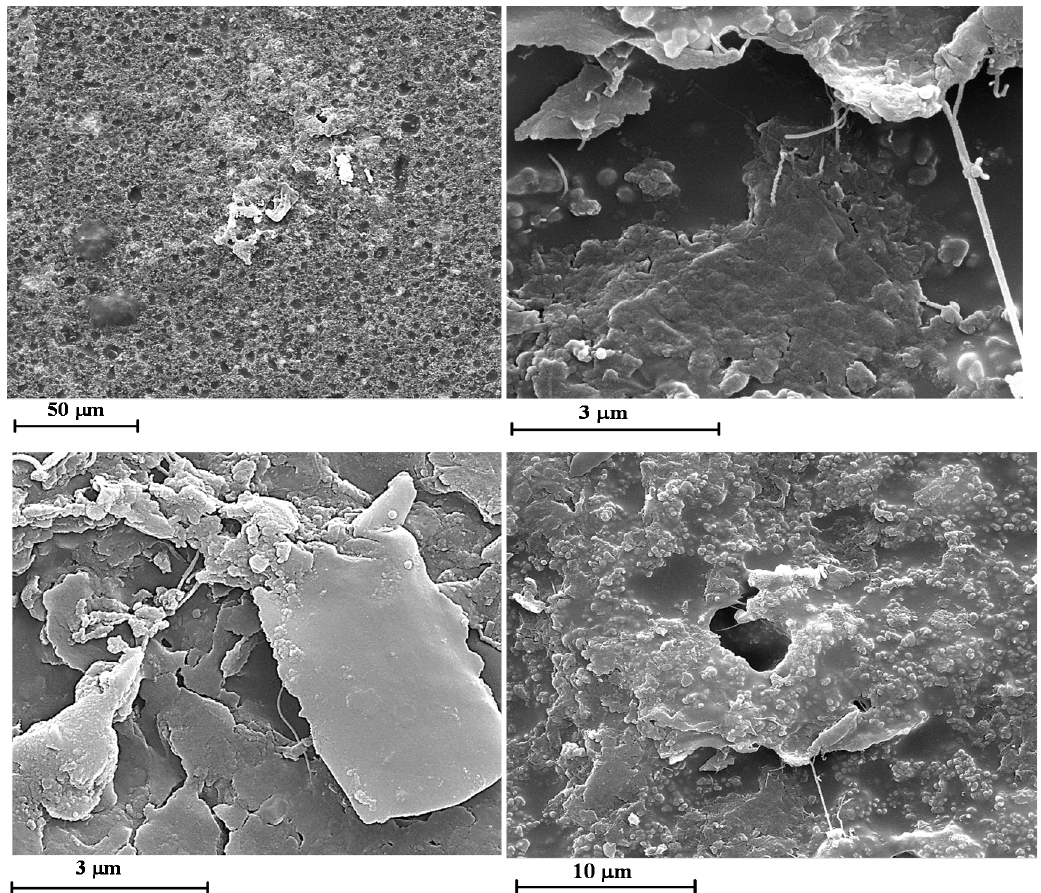
Figure 6. SEM micrographs of the unfilled films after 550 h of UV irradiance (0GNPs (550) sample) at different magnifications.